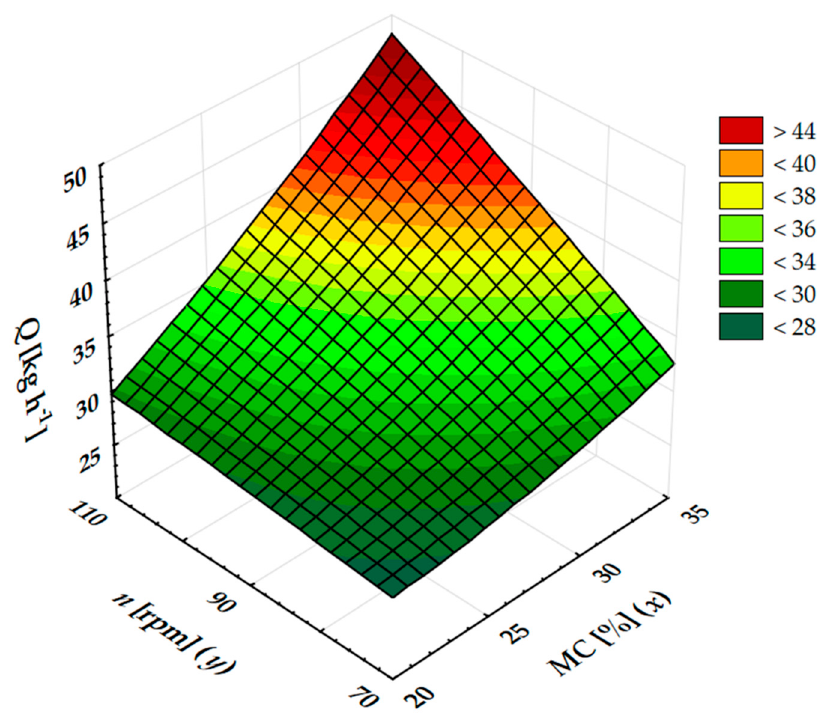
Figure 2. The influence of the rotational speed of the extruder screw and the level of raw material moisture on the efficiency of the extrusion process.